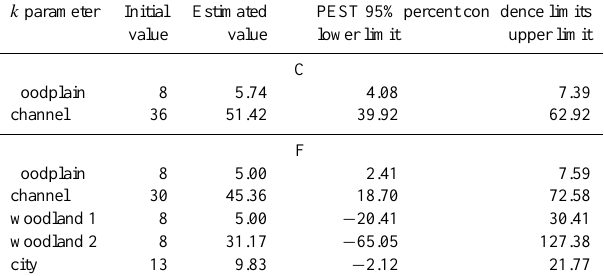
k parameter Initial Estimated